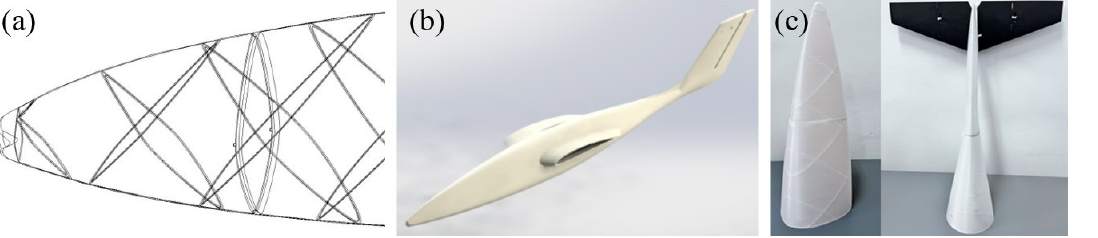
Figure 2. 3D model of UAV fuselage. ( a ) 3D transparent view; ( b ) rendered 3D fuselage; ( c ) AMed fuselage sections.